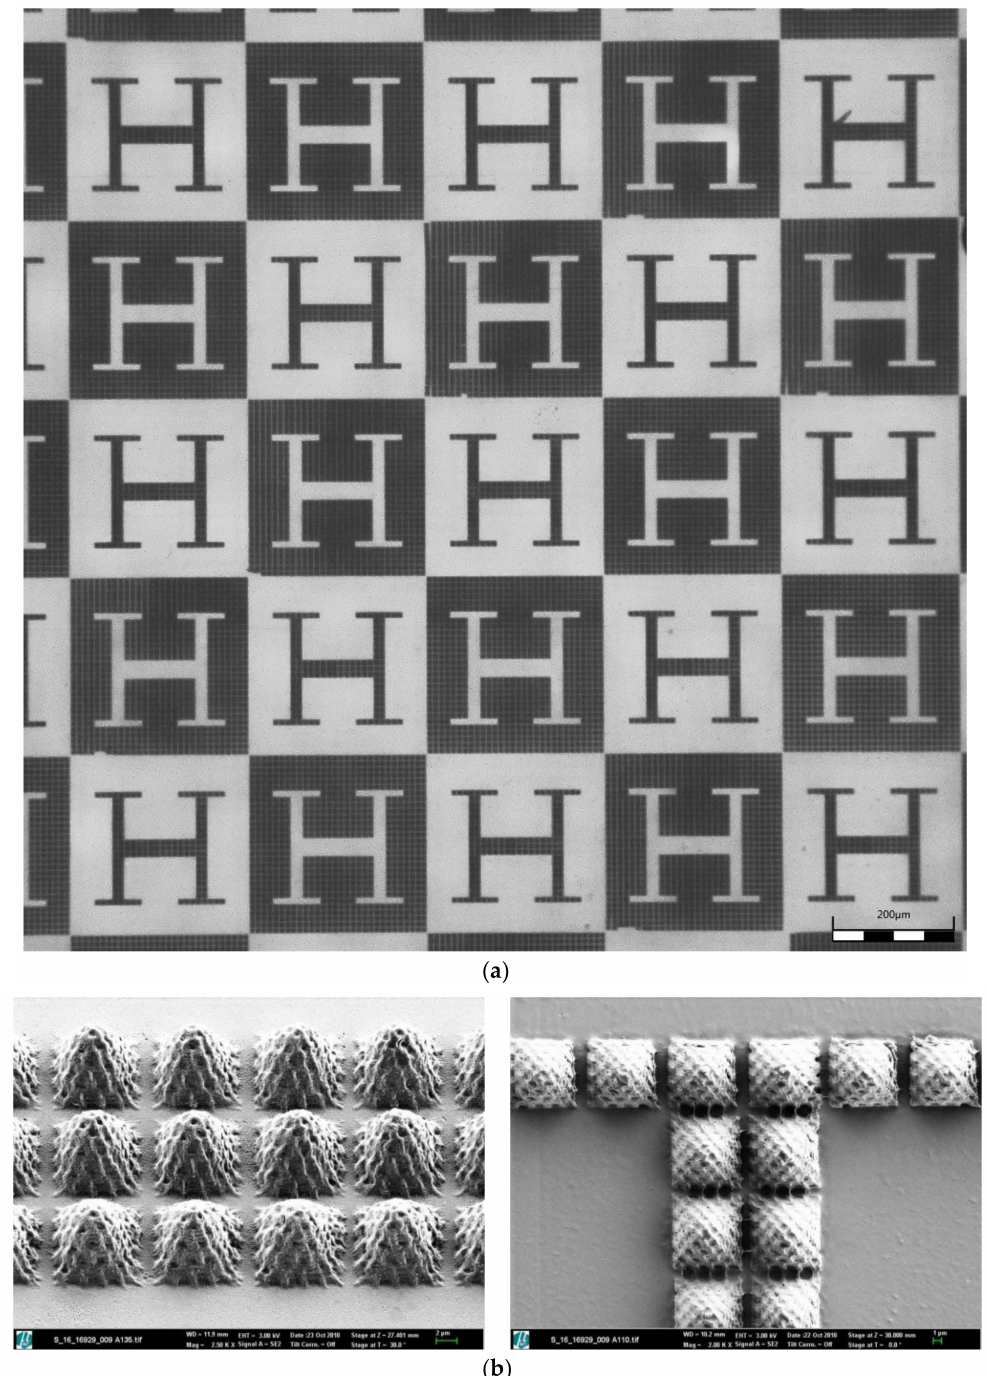
Figure 3. ( a ) Microscopy of hot embossed template after direct laser writing of master models, metallization and pattern transfer to poly (methyl methacrylate) (PMMA) foils. ( b ) Details of hot embossed microstructures showing a remarkable similarity with the original CAD